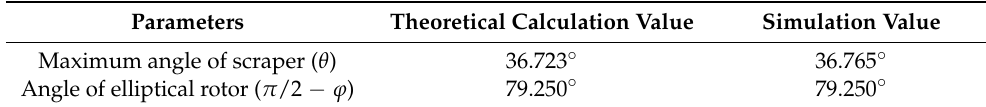
Figure 7. The curve of the rotation angle of the rotor. Table 2. Comparison between the simulation and theoretical model. Table 2. Comparison between the simulation and theoretical model.